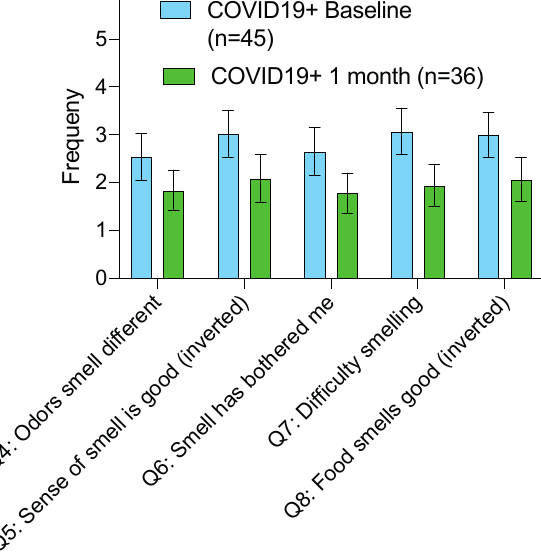
S4. COVID-19 + Patients Reported Improved Nasal/Facial Pain and Congestion 1 month Compared to Baseline. There was a signifi- cant improvement in self-reported nasal/facial pain and congestion in COVID-19 + patients at baseline (blue) compared to 1 month later (green). There was no significant difference in nasal drainage. Error bars represent 95% confidence intervals. Questions are answered